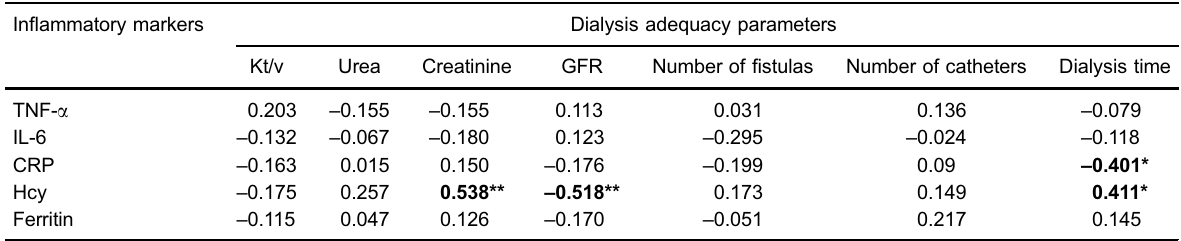
Table 5. Spearman ’ s correlation coef fi cients between in fl ammatory markers and dialysis adequacy parameters. In fl ammatory markers